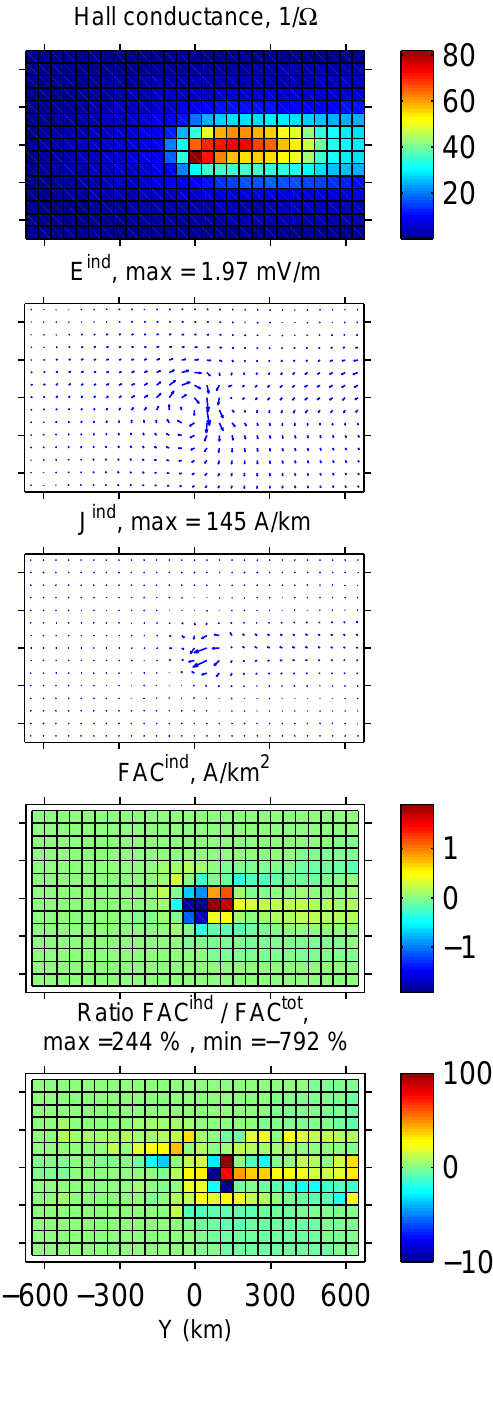
of upward FAC being ∼ 80% of the downward FAC. This excess downward FAC feeds the intensifying western part of the electrojet. In the induced system there is ∼ 15% im- balance in the opposite direction, whith the excess induced FAC flowing upwards in the transition region between the